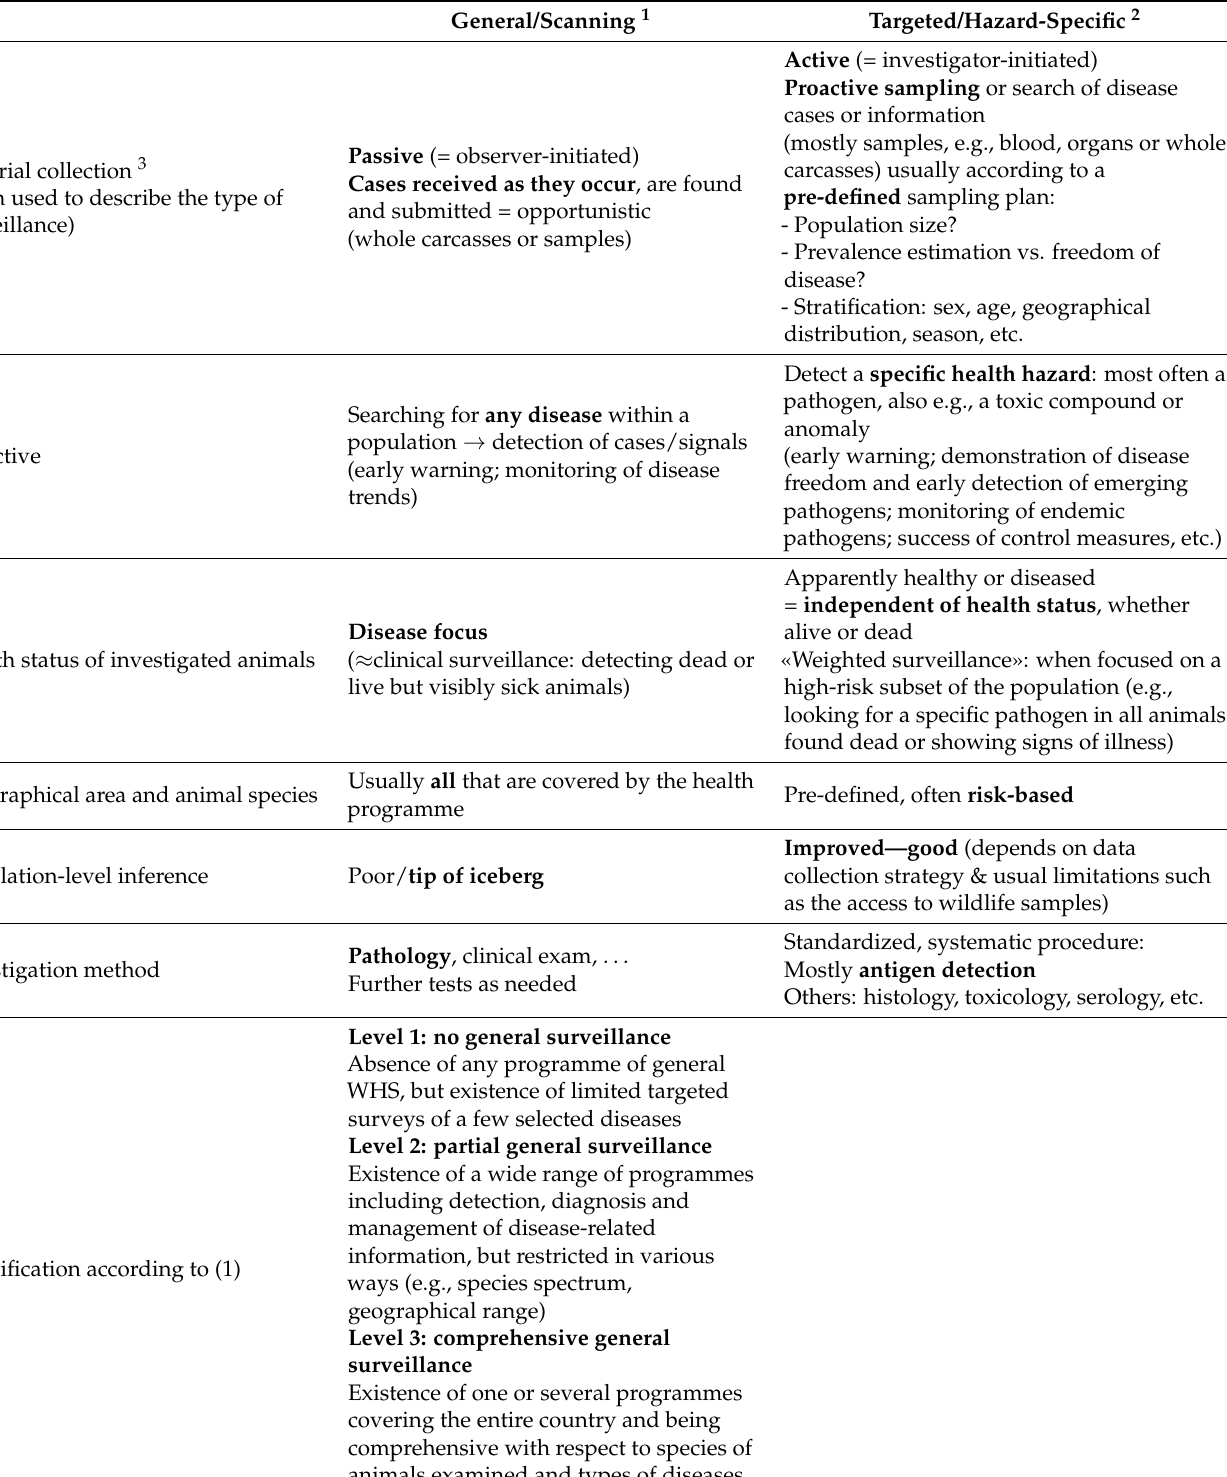
Table 1. Tentative compilation of the definitions of general and targeted surveillance. The following sources of information were taken into consideration